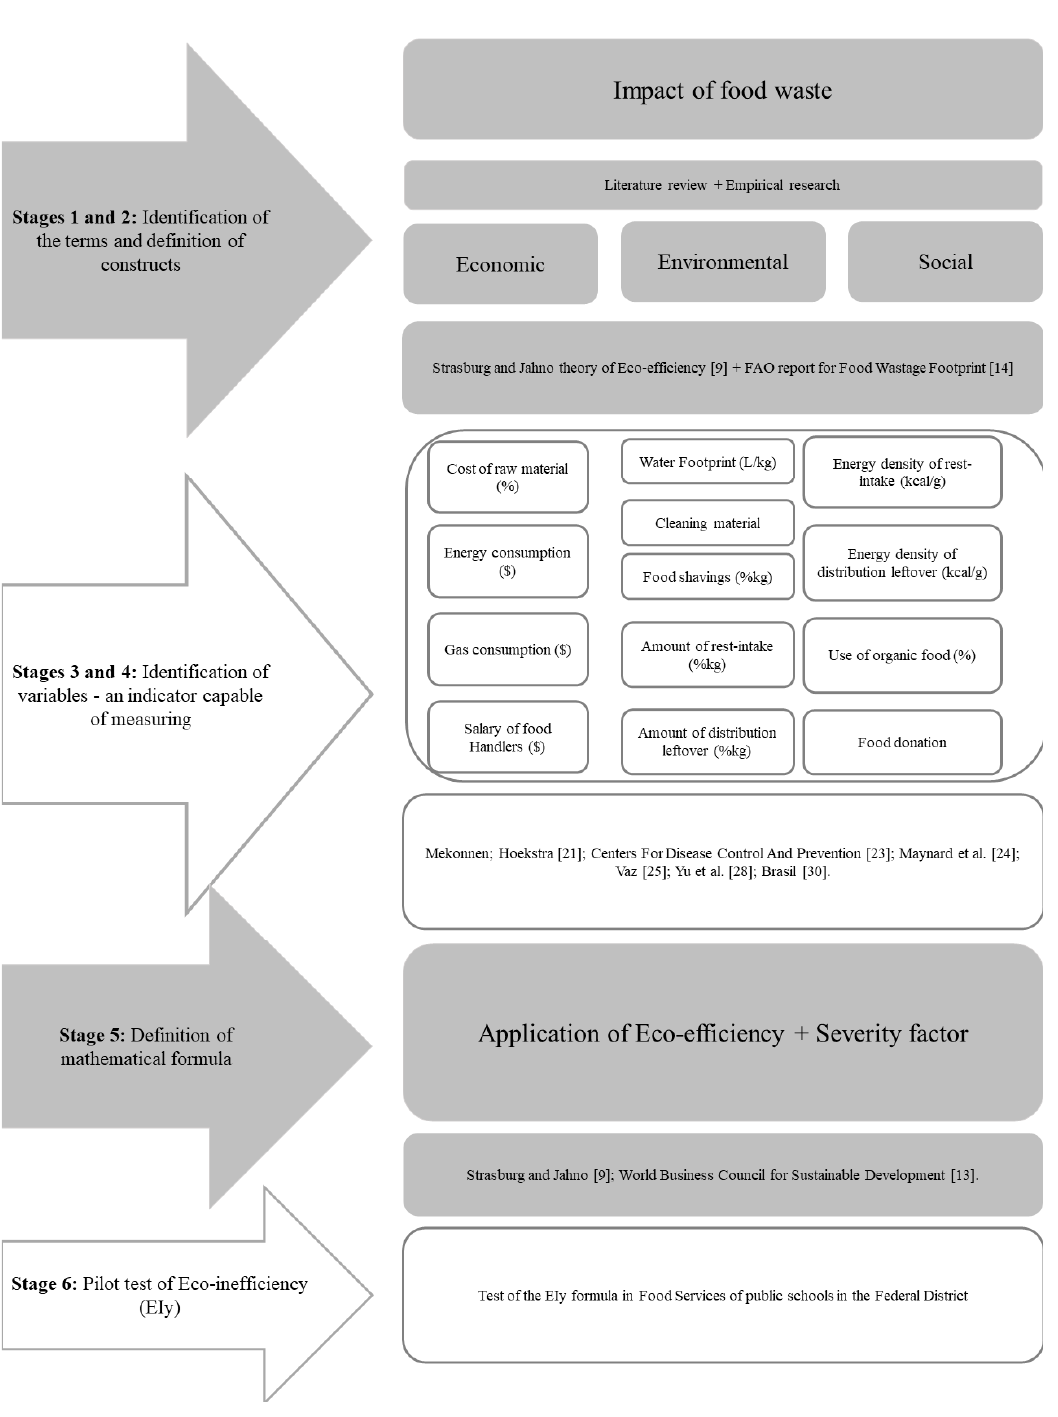
Figure 1. Diagram of the development of the mathematical formula of eco-inefficiency, a waste impact indicator on food services.